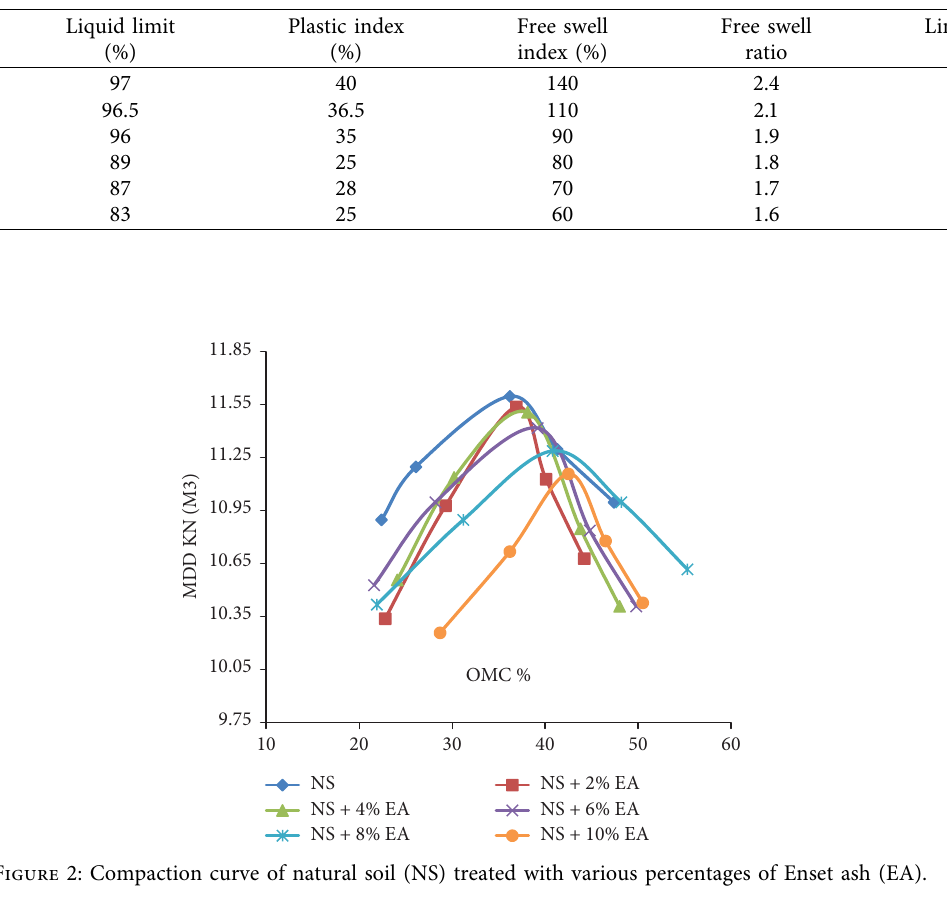
Table 5: Summary of index properties of treated and raw soil samples.